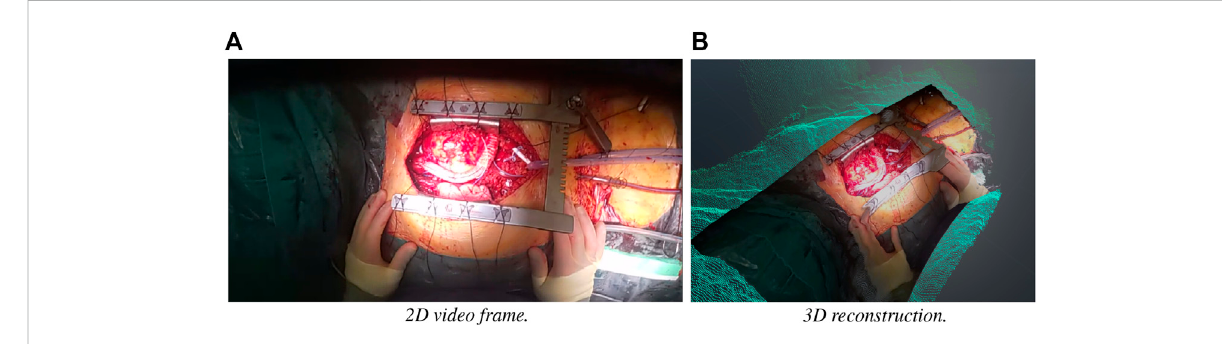
FIGURE 9 One frame of the recording used in the study. (A) RGB image in the video stream, (B) 3D reconstruction as point